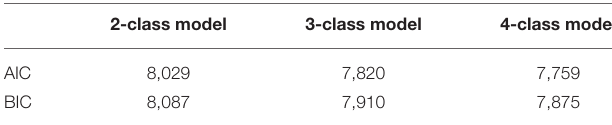
TABLE 3 | Latent class model fit statistics of participants with metabolic syndrome in 2014.